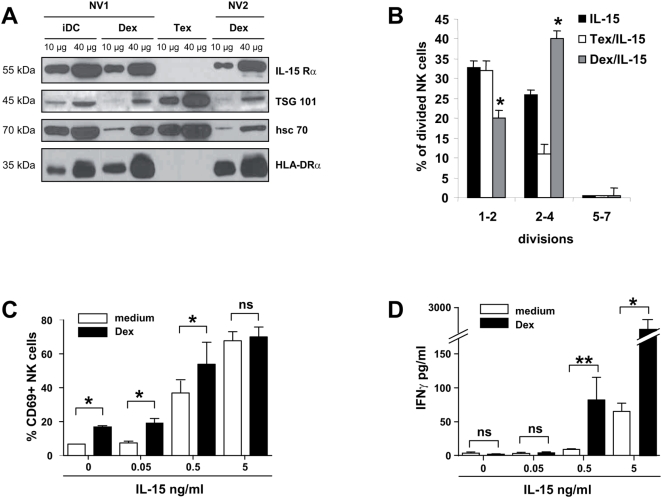
Human Dex harbour functional IL-15Rα and synergize with IL-15 for NK cell proliferation in vitro and IFNγ production in vitro.

A.
 Immunoblotting of IL-15Rα from Dex and DC lysates. Western Blot analysis on 10–40 µg of protein lysates obtained from immature DC (iDC), Dex or Tex (exosomes from Mel888 melanoma cell line) using anti-IL-15Rα mAb. Positive controls included anti-HLA-DRα, -TSG 101 and -HSC 70 Abs. Representative immunoblots of two normal volunteers are depicted (NV1 and NV2). Molecular weights are indicated on the left lane. B. Proliferative effects of recombinant IL-15 and Dex on NK cells. CFSE-labeled NK cells were cultured with or without 10 µg autologous Dex or allogenic Tex in complete medium containing 0.5 ng/ml of human recombinant IL-15. At day 6 of culture, NK cell proliferation was determined by flow cytometry and the number of divisions were counted and depicted. A representative experiment out of two is shown. C–D. Synergistic effects between Dex and recombinant IL-15 for NK cell triggering. NV's PBL were cultured without (white histograms) or with (black histograms) 10 µg autologous Dex and increasing concentrations of human recombinant IL-15. NK (CD56+ CD3−) cells were then analysed for CD69 expression by flow cytometry (C) or supernatants were harvested to measure IFNγ levels in EIA (D). The graphs depict means±SEM of % of CD69 expressing NK cells in 3 experiments (C) or IFNγ concentrations in 4 experiments (D). * p<0.05, ** p<0.01 and ns: non significant.